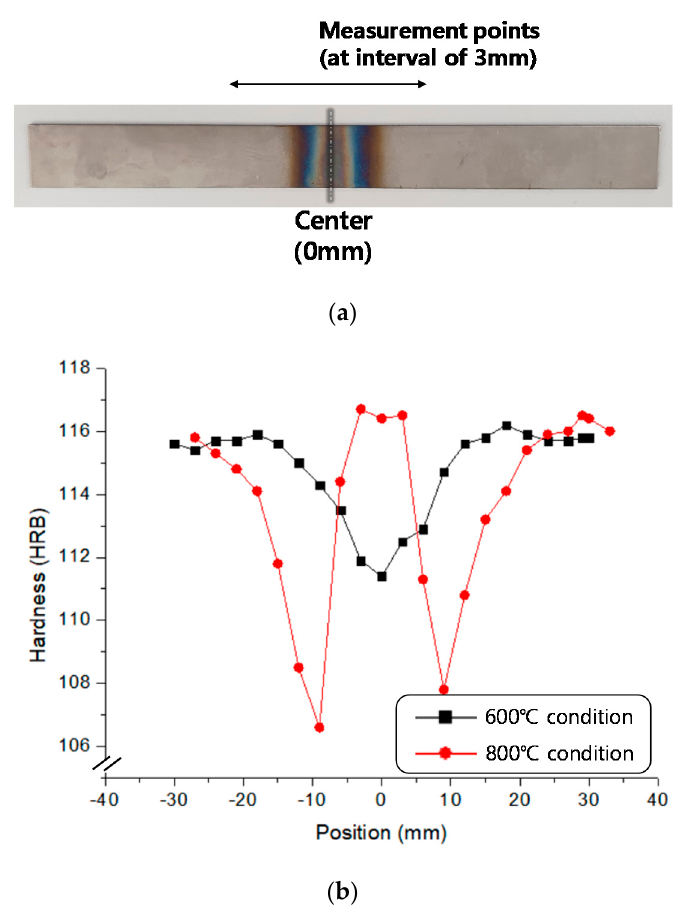
Figure 8. Hardness distribution of the 600 and 800 °C-heat-treated specimens: ( a ) Hardness measurement setting; ( b ) Hardness distribution.